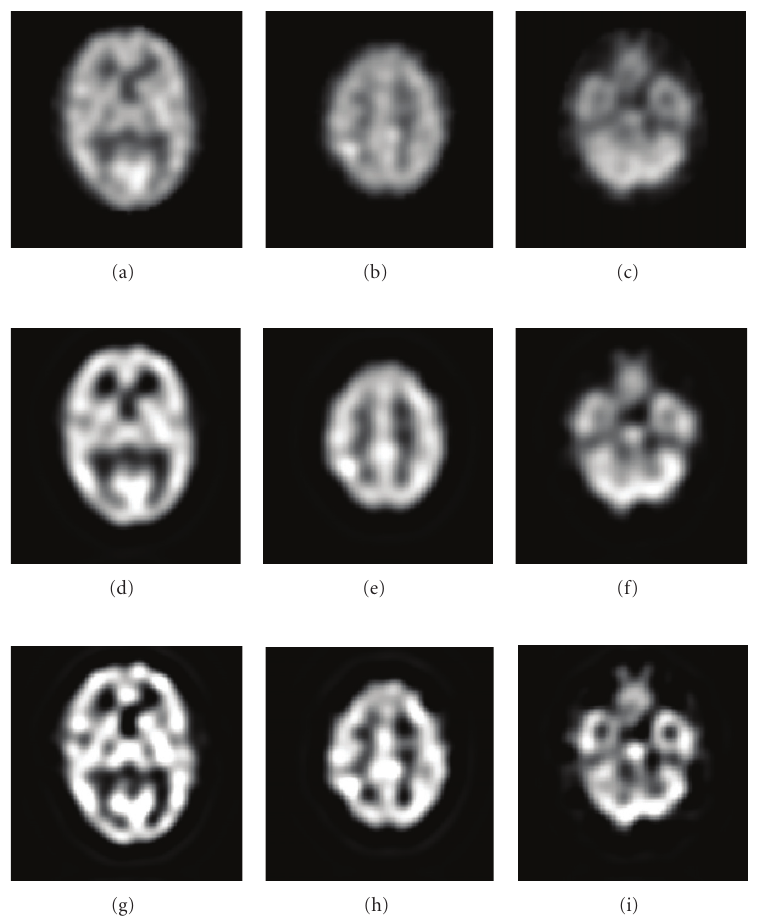
Figure 8: Examples of deconvolutions for the Ho ff man phantom. (a), (b) and (c): Original SPECT cross-sectional images. (d), (e) and (f): deconvolution result with Metz filter. (g), (h) and (i): deconvolution result with our